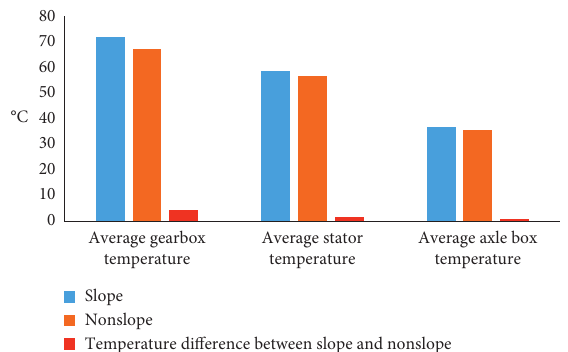
Figure 3: Comparison of bearing temperature on ramp.